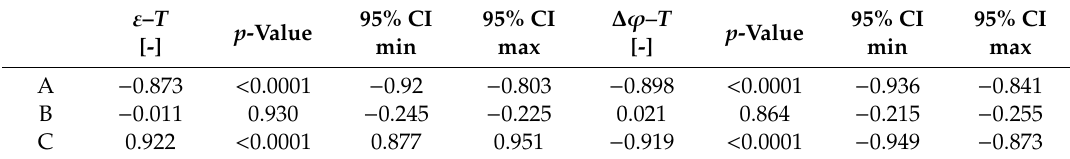
Table 4. Correlation coe ffi cients and statistical parameters for all VTs and both parameters ε and ∆ ϕ